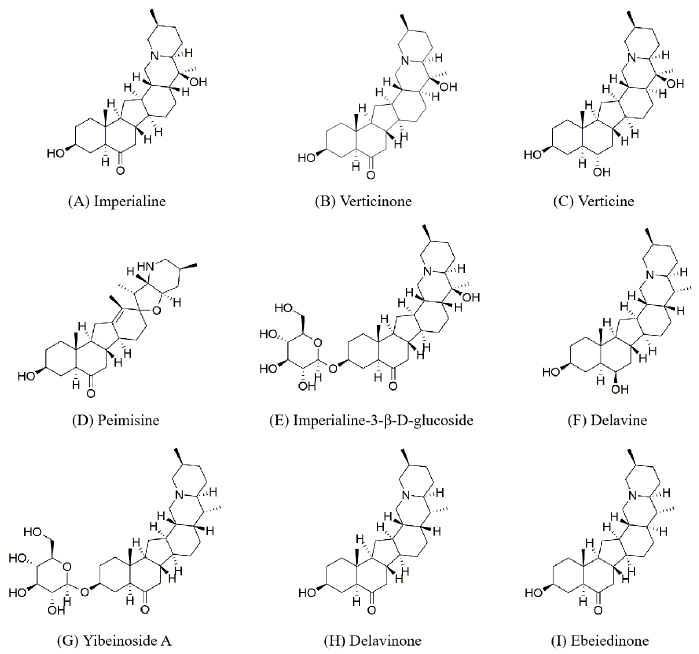
Figure 1. The chemical structures of nine alkaloids: ( A ) Imperialine; ( B ) Verticinone; ( C ) Verticine; ( D ) Peimisine; ( E ) Imperialine-3- β -D-glucoside; ( F ) Delavine; ( G ) Yibeinoside A; ( H ) Delavinone; ( I ) Ebeiedinone.